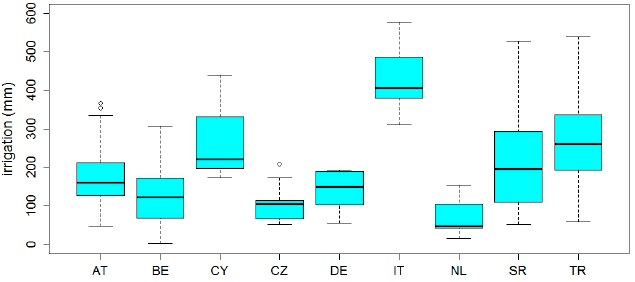
Figure 10. Irrigation (in mm) during the cropping season across the European regions for the period 1992–2012. A two letter code refers to the country that the region belongs to.